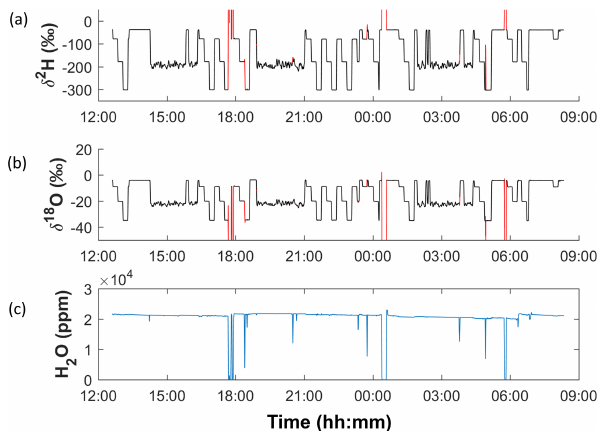
Figure 1. An example of the raw data from a full day of ice melt- ing and calibration cycles (2–3 July 2014): (a) δ 2 H, (b) δ 18 O and (c) water vapour mixing ratio. Isotope data that were removed be- cause of water concentration anomalies are marked in red in (a, b)